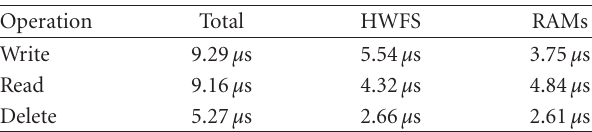
Table 5: Hardware filesystem execution time for a 1KB file with a single ram disk with 64 byte block size.